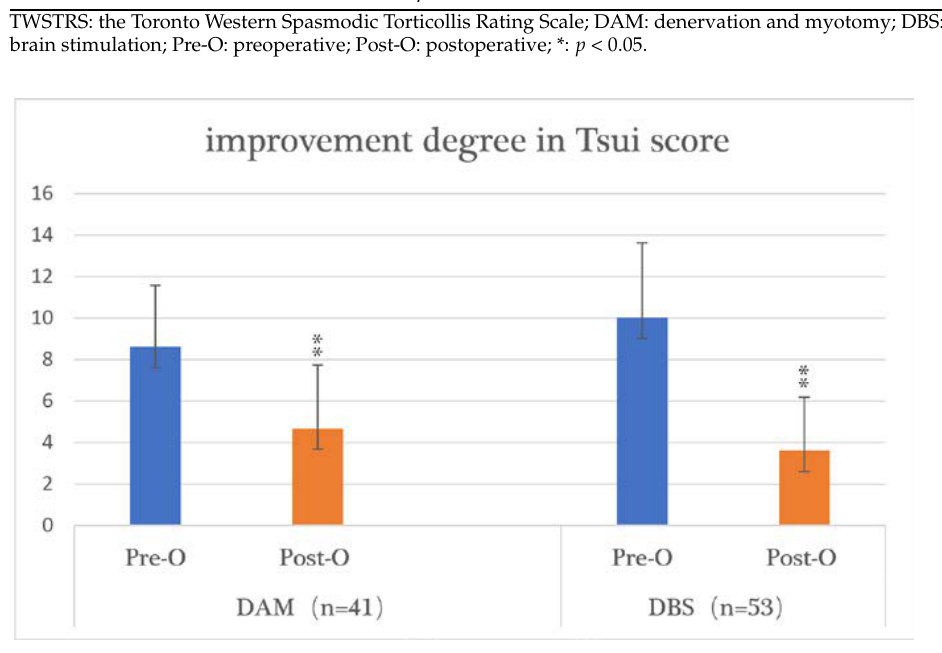
Figure 1. The improvement in Tsui scores in the DAM group and DBS group. TWSTRS: the Toronto Western Spasmodic Torticollis Rating Scale; DAM: denervation and myotomy; DBS: deep brain stimulation; Pre-O: preoperative; Post-O: postoperative; **: p < 0.01.